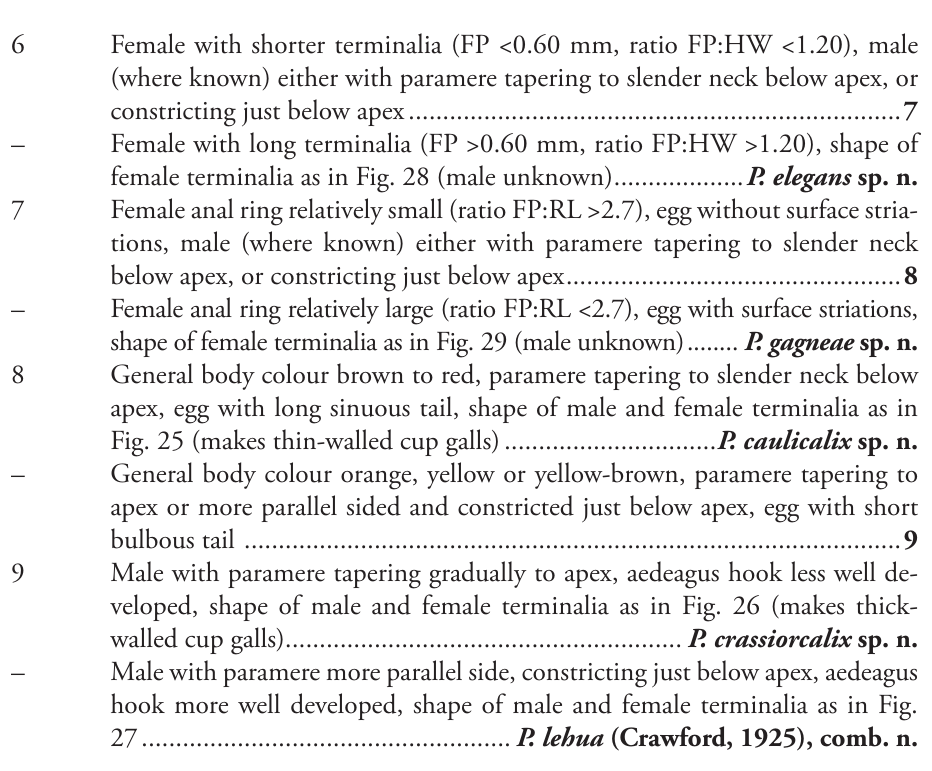
Pariaconus iolani (Kirkaldy, 1902), comb. n. Trioza iolani Kirkaldy, 1902: 114 in part (Kauai specimens, nec Oahu specimens), type designated by lectotypification in 1908: 206; non Trioza iolani Crawford, 1918, nec Zimmerman, 1948. Trioza kauaiensis Crawford, 1925: 29, syn. n. Adult colour. General body colour green, yellow-green or yellow-orange, often with brown on legs, thorax and abdomen. Females may have a darker abdomen due to darkly pigmented egg load. Fore wing membrane clear. Adult structure. Fore wing apex rounded; surface spinules sparsely distributed, usually in all cells except limited or absent from cell r ; long setae on margins and 1 particularly dense on the ventral margin, sparse long setae on veins (Fig. 21A, D). Antennae long (av. length 1.33; ratio AL:HW av. 1.85); genal processes length short- medium and bluntly acute (ratio VL:GP av. 2.04); medium to long setae on vertex and thorax; distal proboscis segment short (av. length 0.09); hind tibia thick, length shorter or subequal to head width (ratio HW:HT av. 0.95) (Fig. 21B–C, F). Male terminalia (Fig. 21E, G–I, K–L): paramere length subequal to proctiger (ratio MP:PL av.